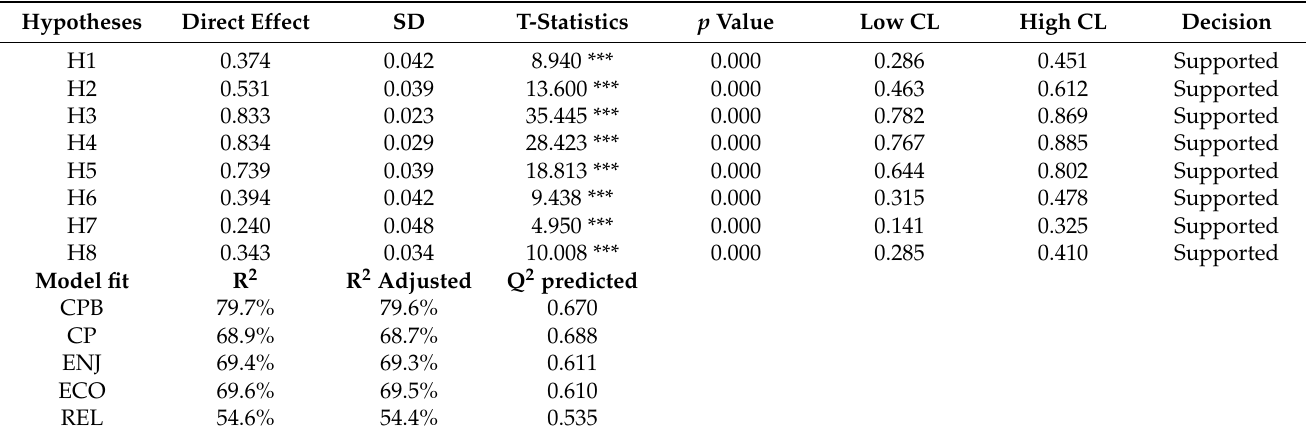
Table 5. Results of research hypotheses and model fit.